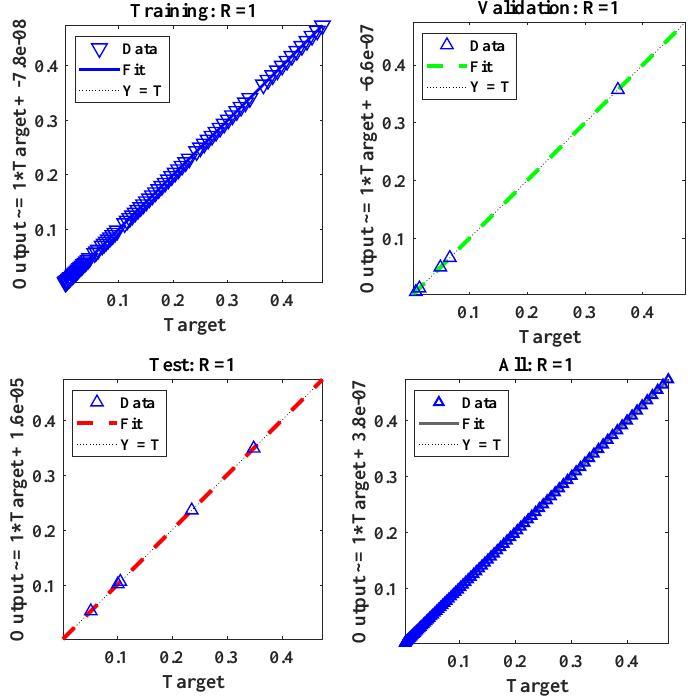
Figure 6. Nonlinear ARX neural network